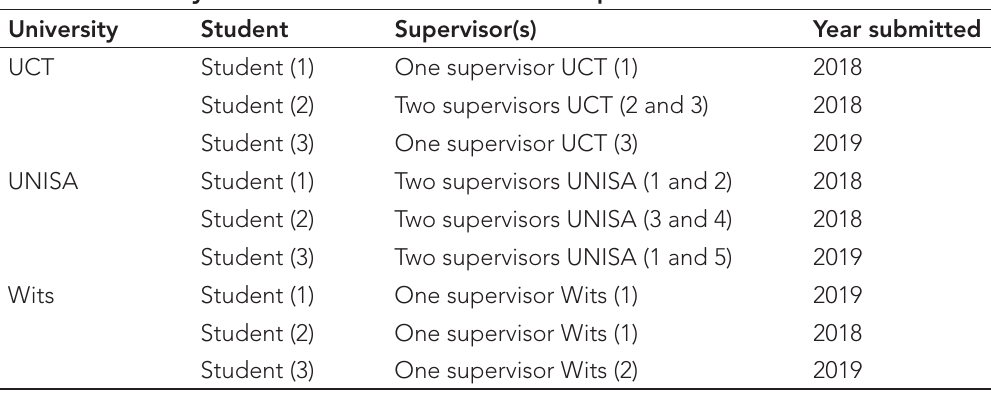
Table 1: Summary of PhD cases included in the